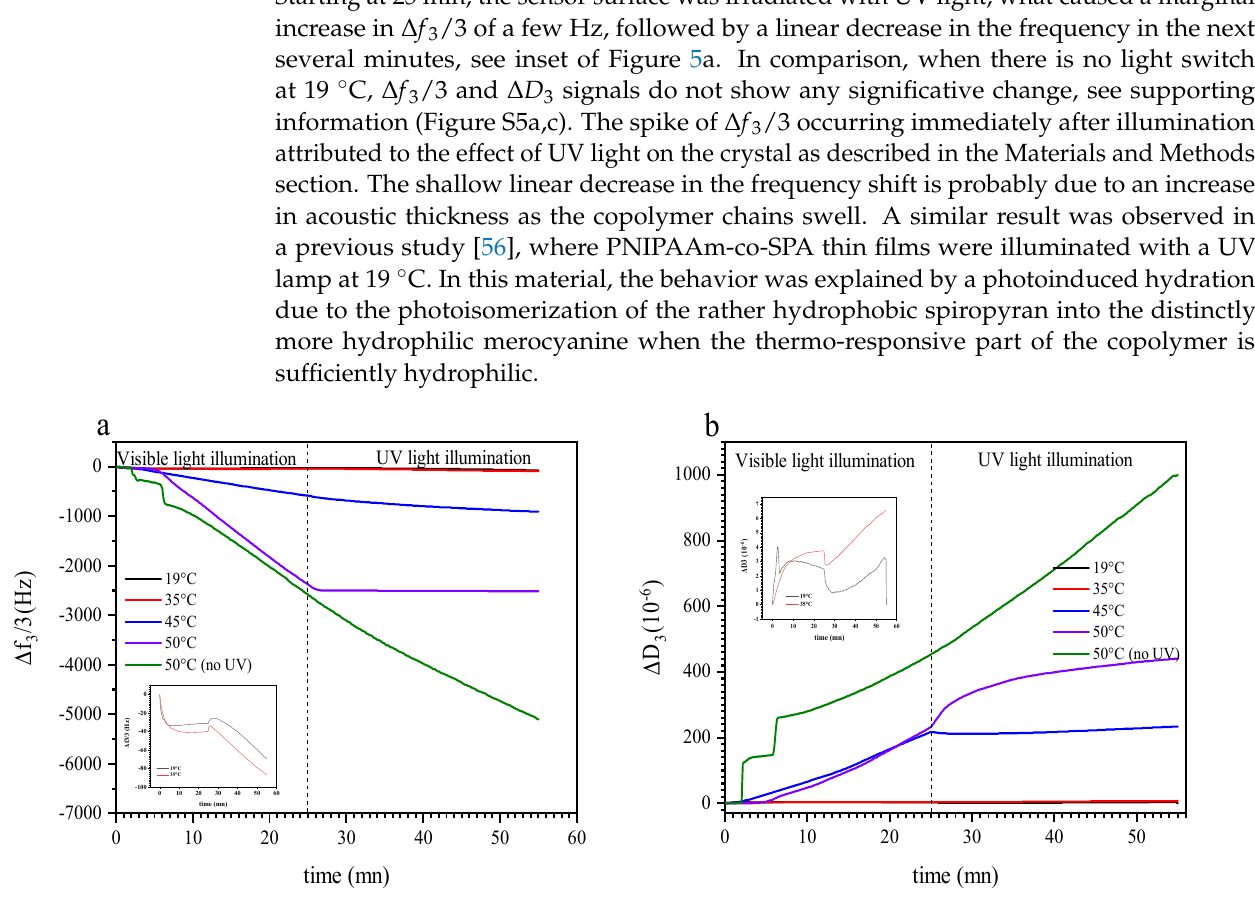
Figure 5. Variation of Δ f 3 /3 ( a ) and Δ D 3 ( b ) versus time of PTEGA-co-SPA at the interface silica-water at a constant tem- perature. The inset is a zoom at Δ f 3 /3 in the range of 19 °C to 35 °C.